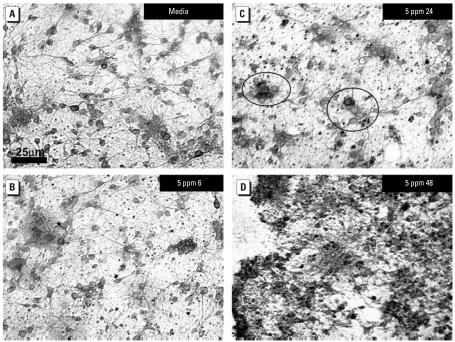
LM histology of IHC rat embryonic striatum. Confluent cultures of embryonic were exposed to 5 ppm P25 for 6–48 hr, IHC stained with NSE and morphometrically analyzed. (A) Untreated cultures consisted of a dense plexus of neurons and glia. (B) Axonal beading and cellular granularity were seen as early as 6 hr postexposure. (C) Evidence of apoptosis (circles) was documented by 24 hr. (D) Complete disruption and loss of cellular integrity was noted by 48 hr postexposure to 5 ppm P25.